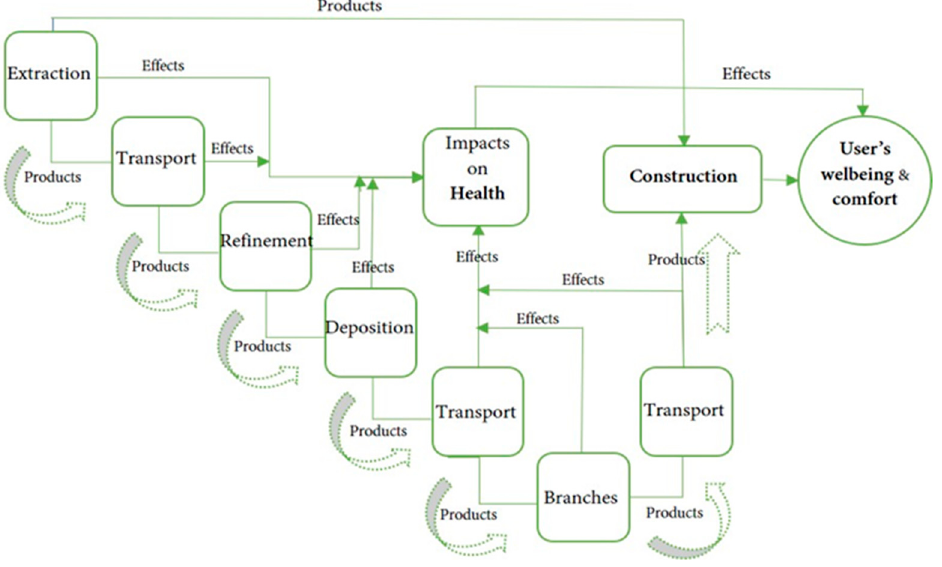
Figure 5. Schematic configuration of general processes that CCMs undergo to deliver construction to user.